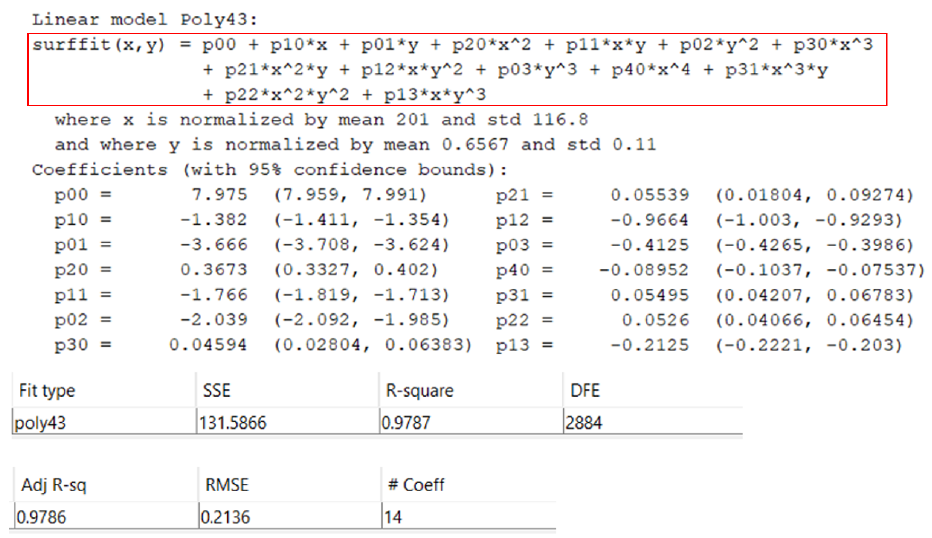
Figure A1. Description of the fit function and of the resulting